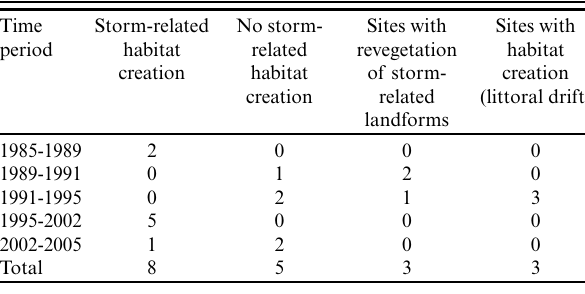
Table 3 . Frequencies of storm-related Piping Plover ( Charadrius melodus melodus ) potential habitat creation/no creation or revegetation, and Piping Plover potential habitat creation through New Brunswick, Canada. Time period creation habitat